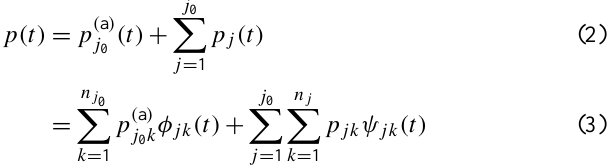
Figure 2. MRA of INS, AMS and MER SM at Kyeamba. p denotes the original time series, p j the detail time series, and p ( a ) mation time series. Grey shadings are > 5 day data gaps, red dots superimposed in p ( a ) lines fitted to p ( a ) 8